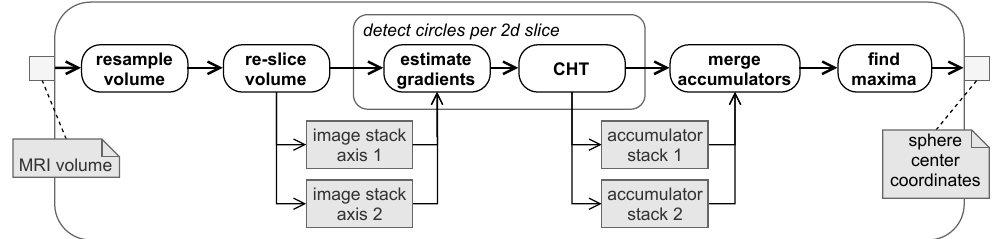
Figure 3. Pipeline for sphere detection based on circular Hough transform